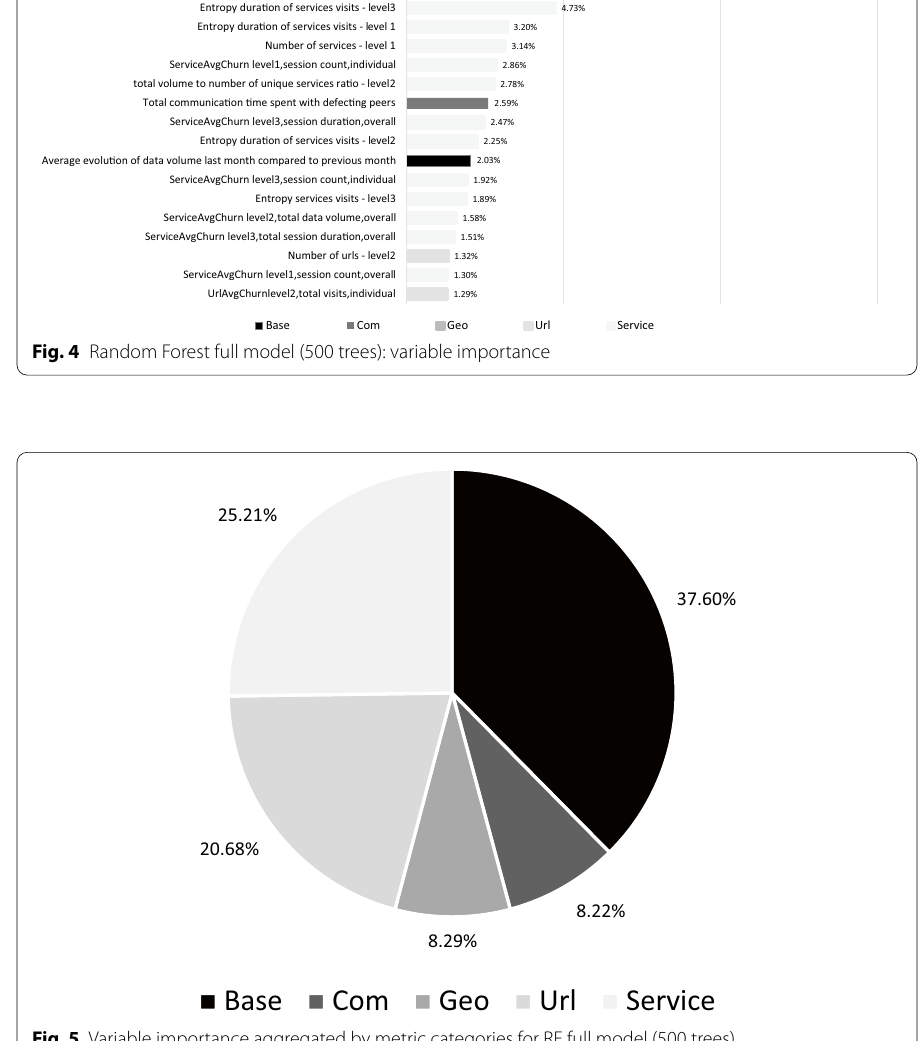
Fig. 5 Variable importance aggregated by metric categories for RF full model (500